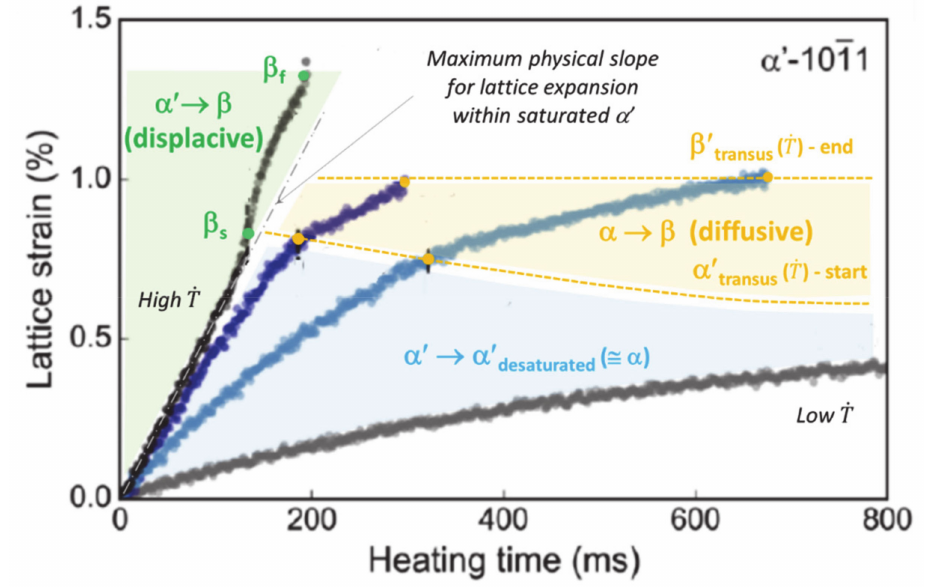
. T ) on the mechanism and transition points of the reverse Figure 1. Influence of heating rate ( transformations of α (cid:48) , as given by the lattice parameter evolution (adapted with permission from ref. [52]. Copyright 2017 Springer